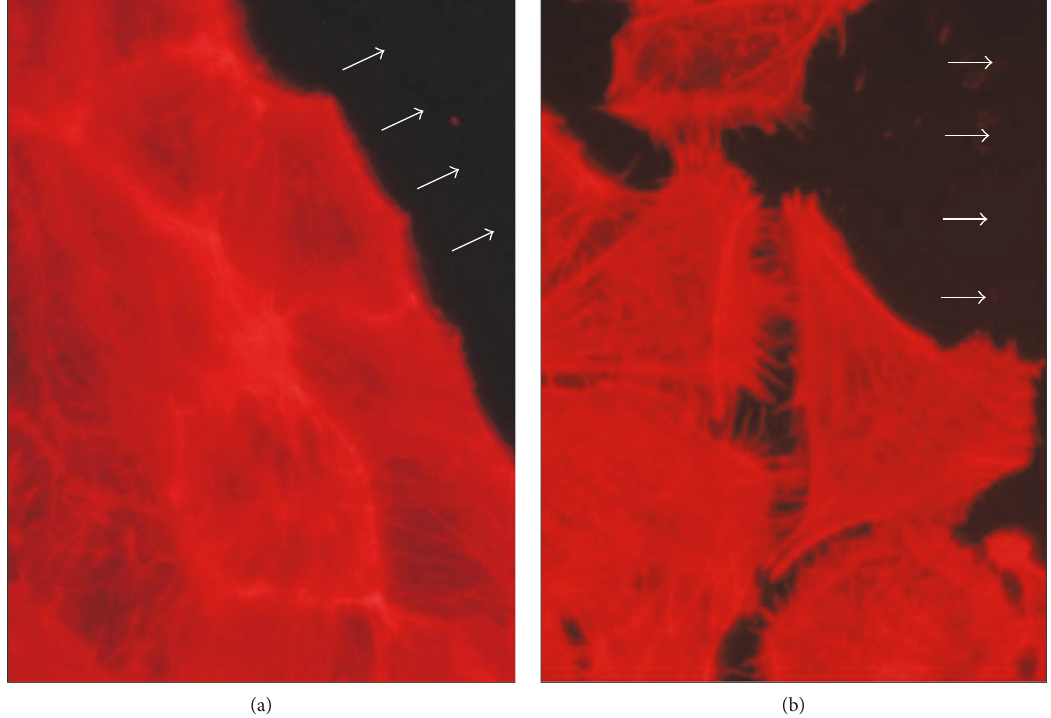
Figure 5: E ff ect of SC-MN on 16HBEC migration. Mechanically injured cells on glass coverslips were treated with saline (a) or SC-MN (1 mg/ml) (b) for 13hrs. Arrows: the direction of cell migration ( fi nal magni fi cation: